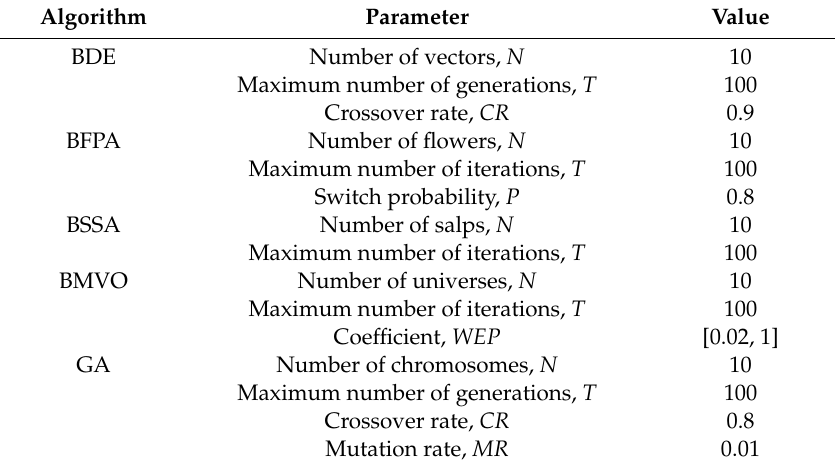
Table 9. Parameter settings of the utilized